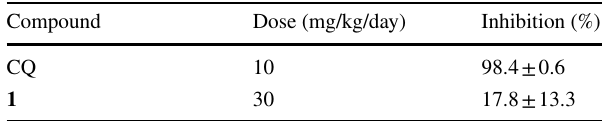
Fig. 2 Key 2D NMR correlations of 1 Table 2 In vivo antimalarial activity of compound 1 against P. yoelii x ± s BY265RFP ( , n =